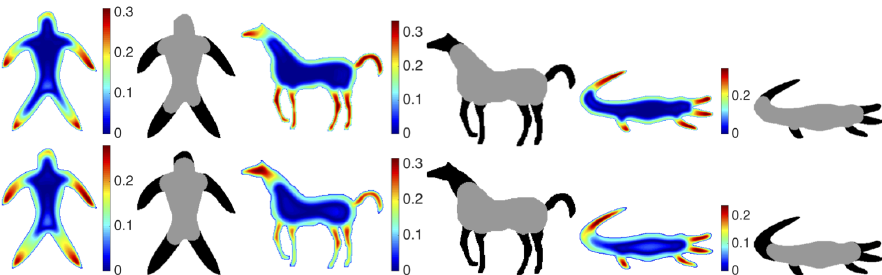
Figure 3. Distinctness values (color coded) and the corresponding mean-value based partitioning (gray vs. black) for three shapes via the feature spaces constructed for ρ (cid:63) = 3 R ( top row ) and ρ (cid:63) = ( 1/2 ) G ( bottom row ). As ρ (cid:63) decreases, gray regions grow.